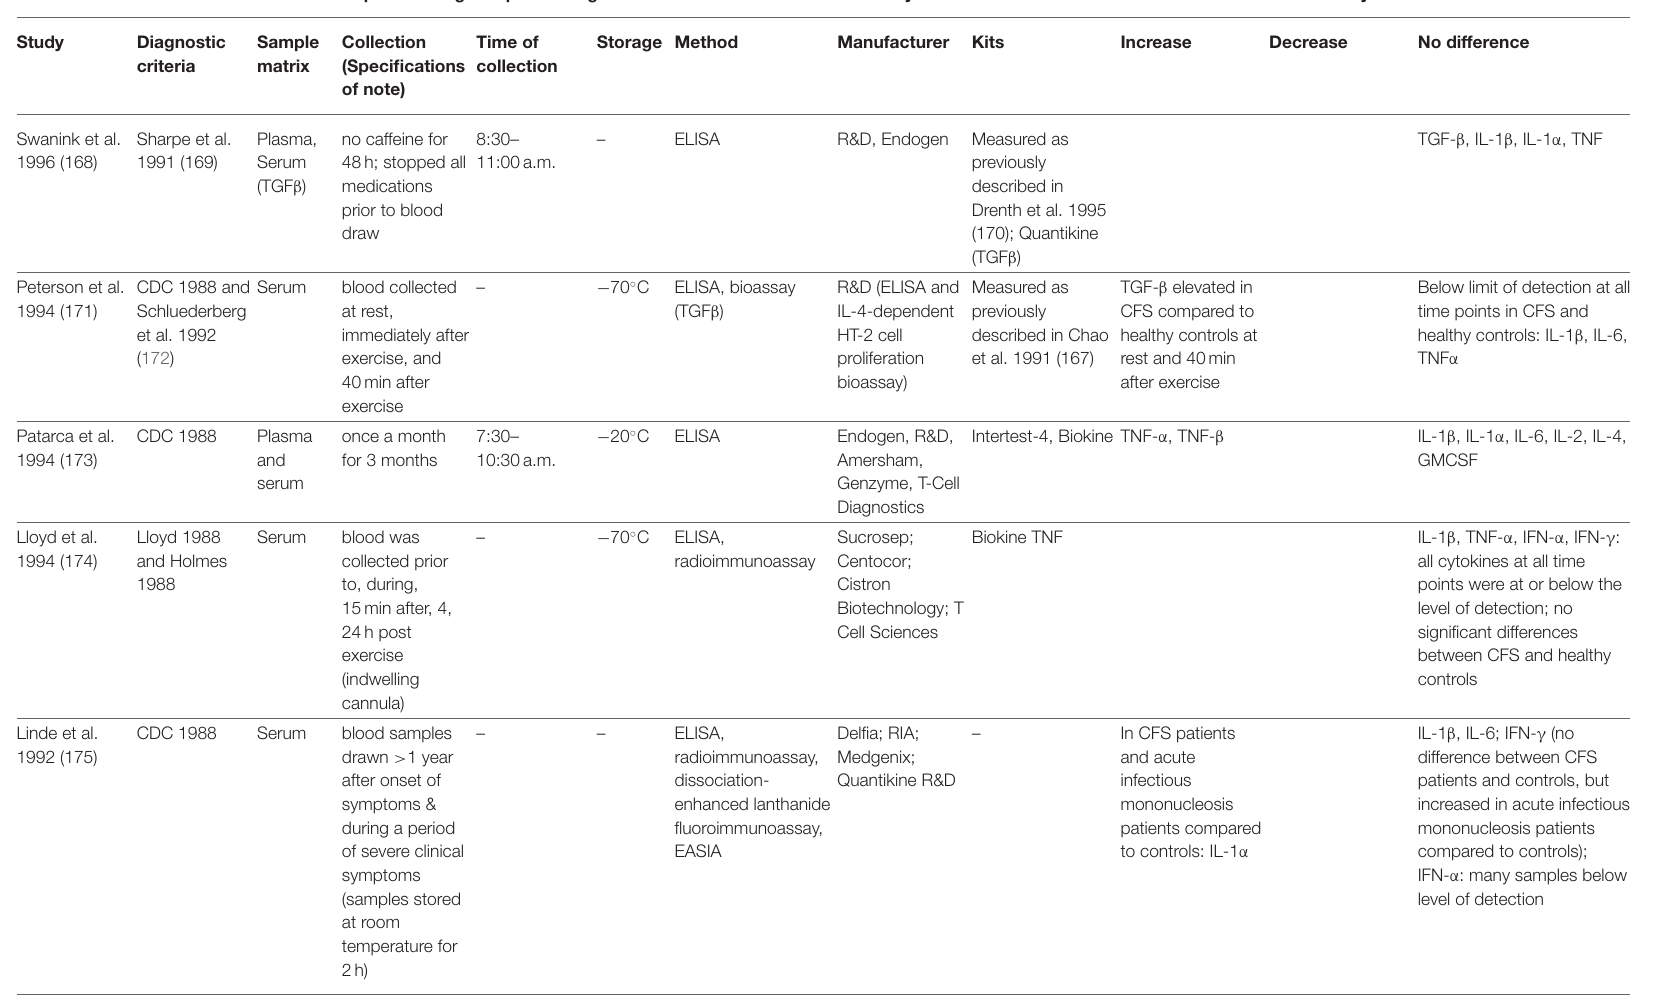
patients compared to controls: IL-1